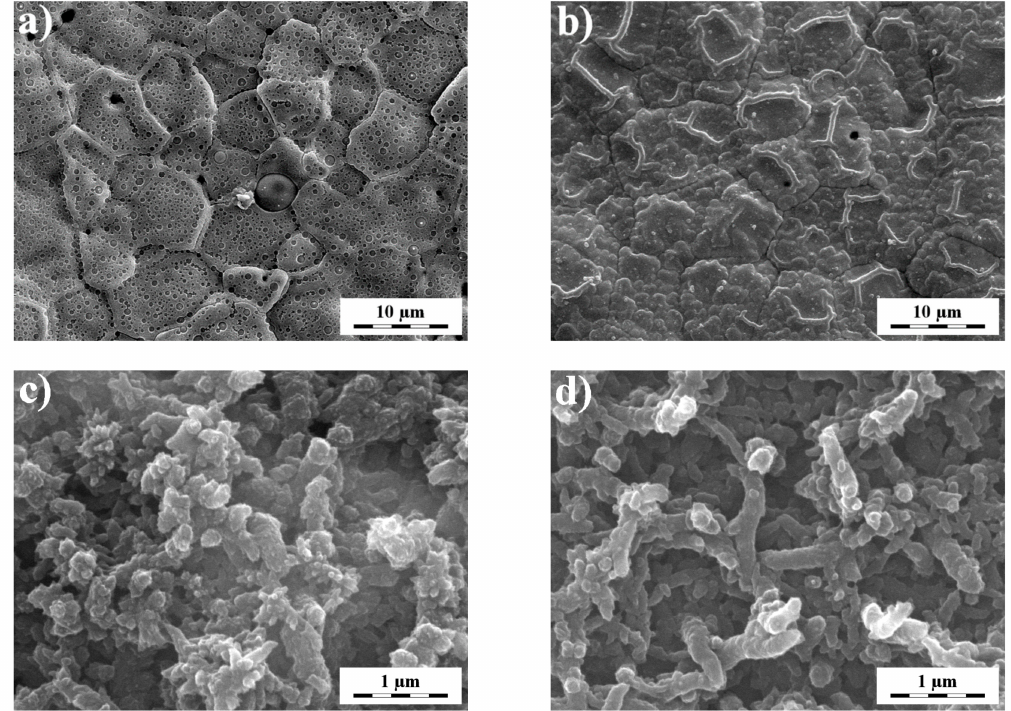
Figure 3. Surface morphology of polymers prepared on different substrates, where the single PNR ( a ) and PTh ( b ) polymer itself are deposited on Pt, the bilayer, where PANI is deposited on PTh ( c ) and the three-layer, where PNR polymer is deposited on the PTh-PANI bilayer ( d